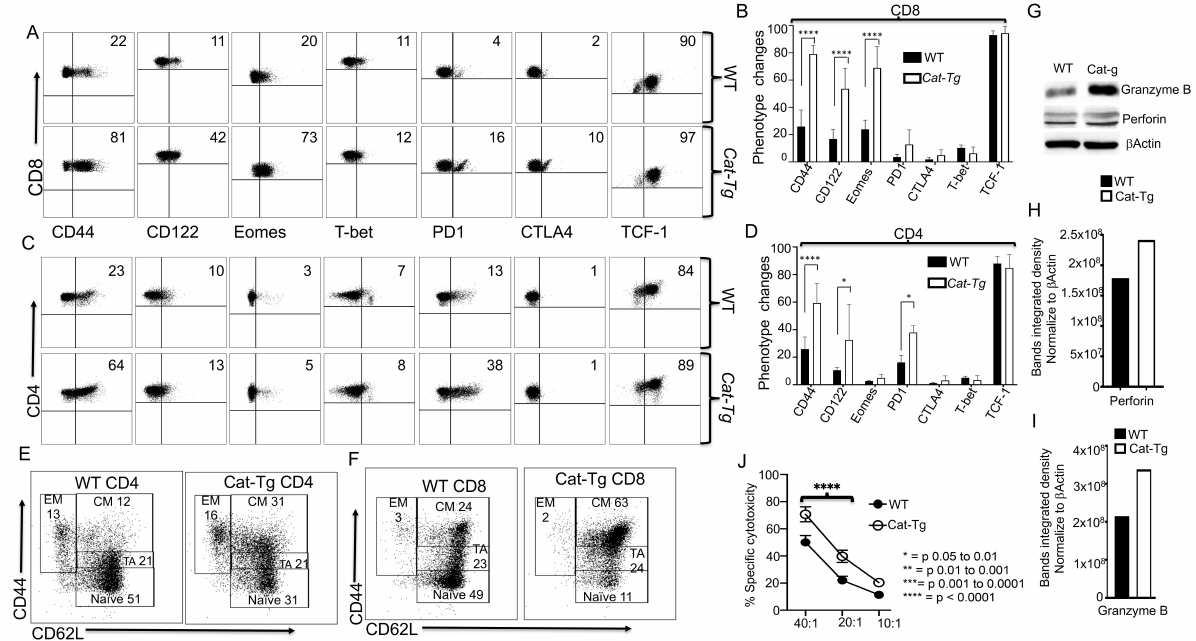
Figure 2. T cells from Cat-Tg mice exhibit enhanced T cell IMP phenotypes and enhanced GVL cytotoxicity. Purified CD3 + T cells from WT and Cat-Tg T cells were examined for expression of CD44, CD122, Eomes, T-bet, PD-1, CTLA-4 and TCF-1 by flow cytometry. These markers were examined for ( A ) CD8 + T cells, quantified in ( B ). These markers were also examined for ( C ) CD4 + T cells, quantified in ( D ). For ( C , D ), combined data from three separate experiments are shown. ( E ) CD4 + and ( F ) CD8 + T cells from WT and Cat-Tg mice were examined for effector memory (EM), central memory (CM), transitioning to activation (TA), and naïve population frequencies. ( G ) Purified T cells were examined for expression of perforin, granzyme B, and β -actin by Western blot. ( H , I ) Quantitative analysis of perforin ( H ) and granzyme B ( I ) expression from Western blot data, normalized against β -Actin. ( J ) Ex vivo purified T cells were used in a cytotoxicity assay against primary tumor target B-ALL luc + cells at a 40:1, 20:1, or 10:1 effector to target ratio. Statistical analysis was performed using two-way ANOVA, one-way ANOVA confirmed by Student’s t -test, p -values are presented. Symbol meanings for p -values are: ns— p > 0.05; * p 0.05; **** p 0.0001 ( n = 3 mice per group). ≤ ≤